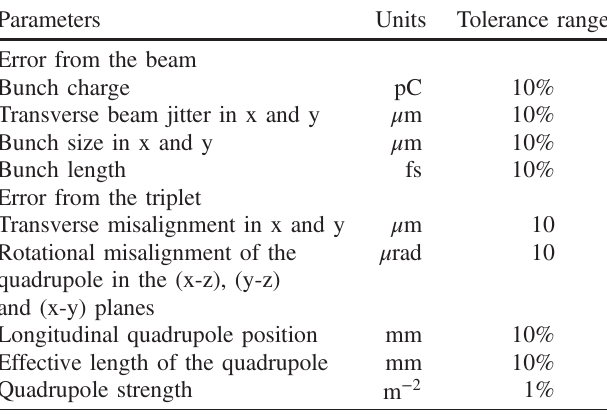
TABLE IV. Maximum tolerable variations in the input param- eters for the electron beam at the BC exit, passing through the PMQ triplet and of the PMQ triplet. The shown variations correspond to the case when all other parameters are also varying from their design values within the range.